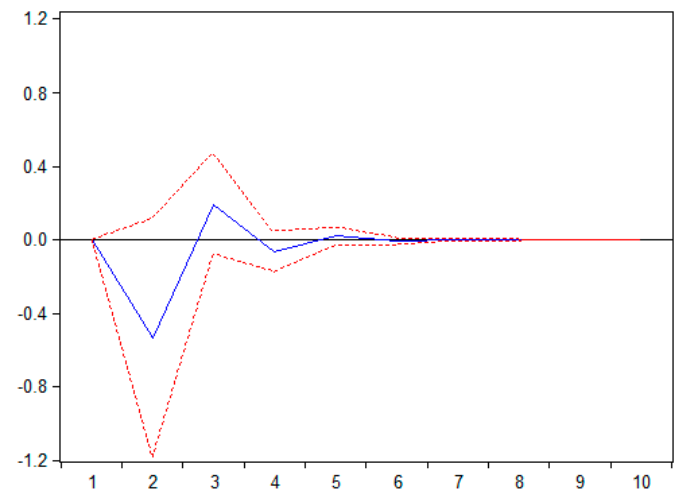
Figure 4. Redenomination risk growth rate impulse response to a unit shock of daily banks’ stock price percentage change. Source: authors’ calculations in Eviews 10 based on Bloomberg data.